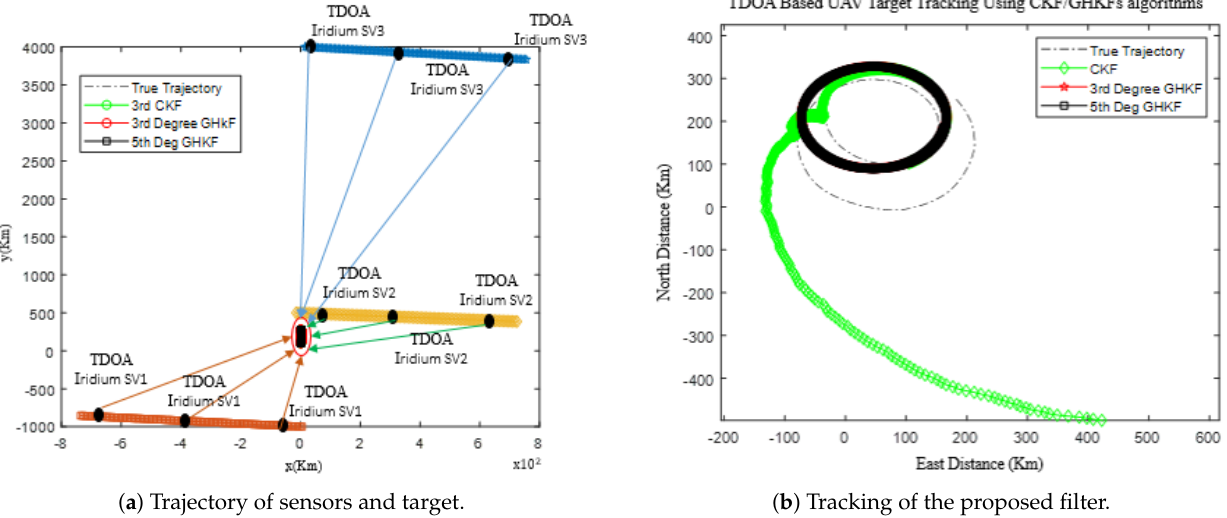
Figure 29. Three (03) Iridium satellites were employed to track a UAV based on a TDOA measurement. Authors’ own